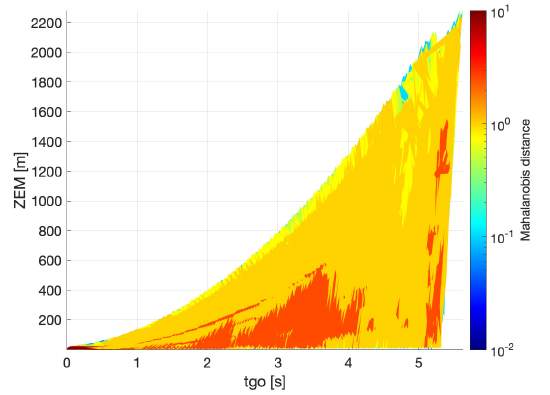
Figure 8. d M ( ZEM ) from the filter—Bearings only